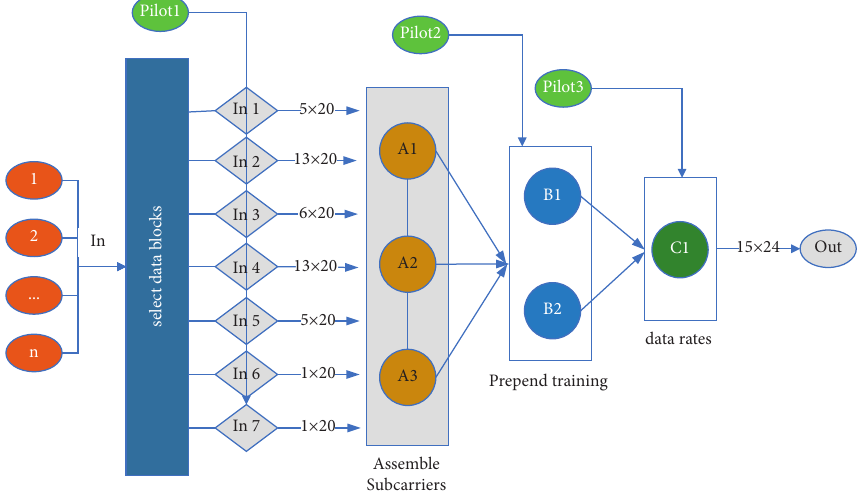
Figure 2: OFDM frame fusion module based on the structure of high-speed hydroacoustic OFDM communication